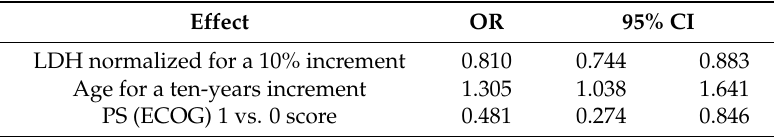
Figure 3. ROC curve of the final multivariate model applied on the validation set with an AUC value of 0.685. Table 2. Overall Odd Ratio (OR) estimates and 95% Confidence Interval (CI) for each variable of the final model.